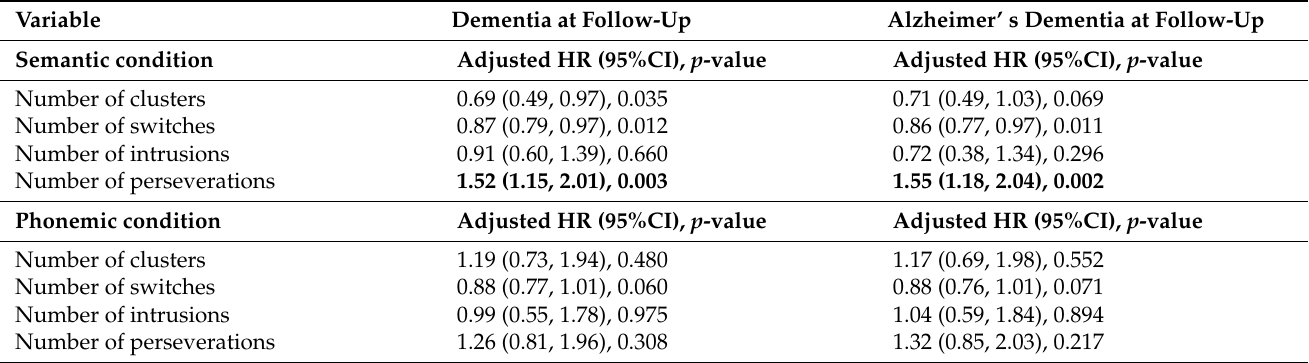
Table 3. Associations between qualitative verbal fluency indices and incident all-cause dementia (primary outcome) and Alzheimer’s dementia (secondary